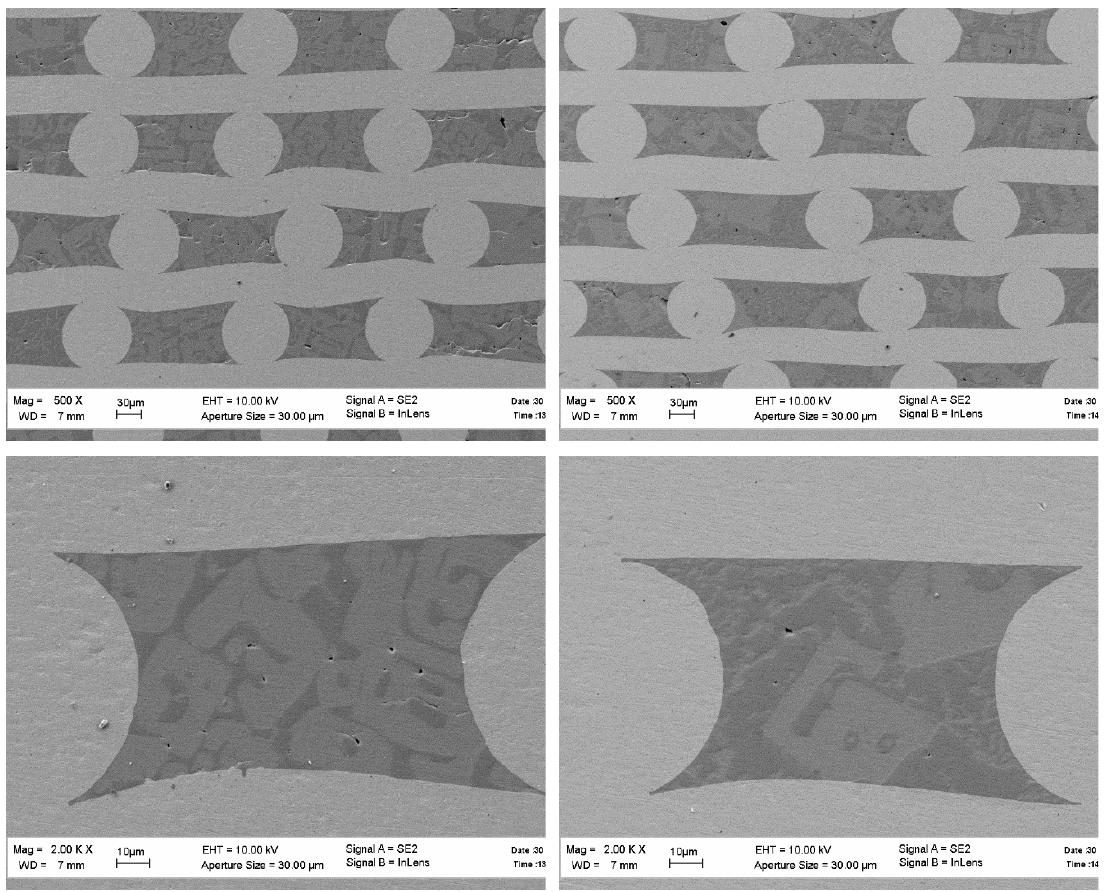
Figure 6. X-ray spectra of the fibers crystallized at various rates. The raw oxide mixture was sintered at 1250 ° С .